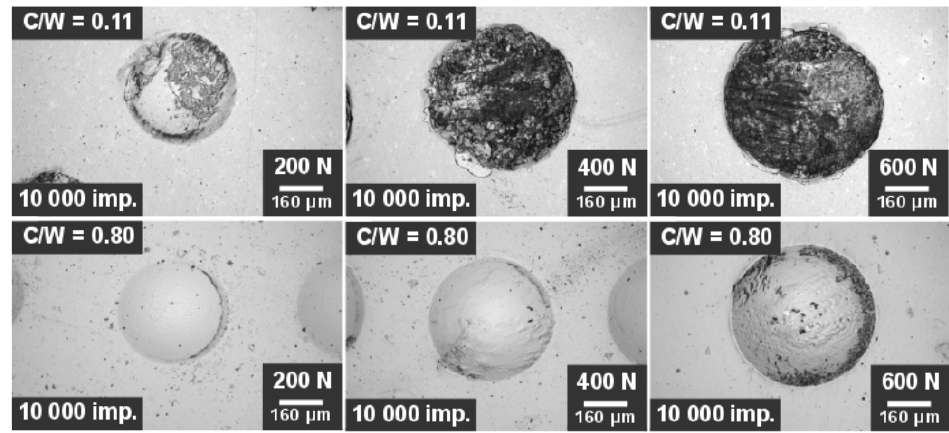
Figure 2. Comparison of impact craters created by 10 000 impacts.